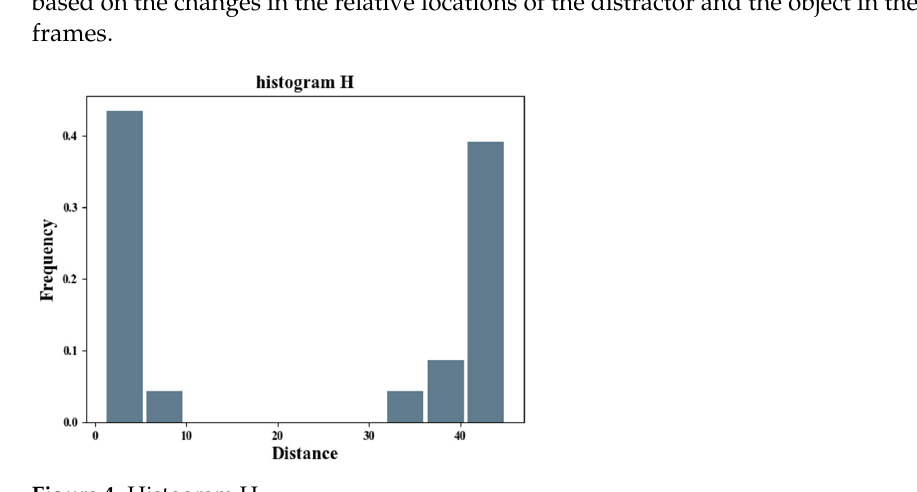
Figure 4. Histogram H.